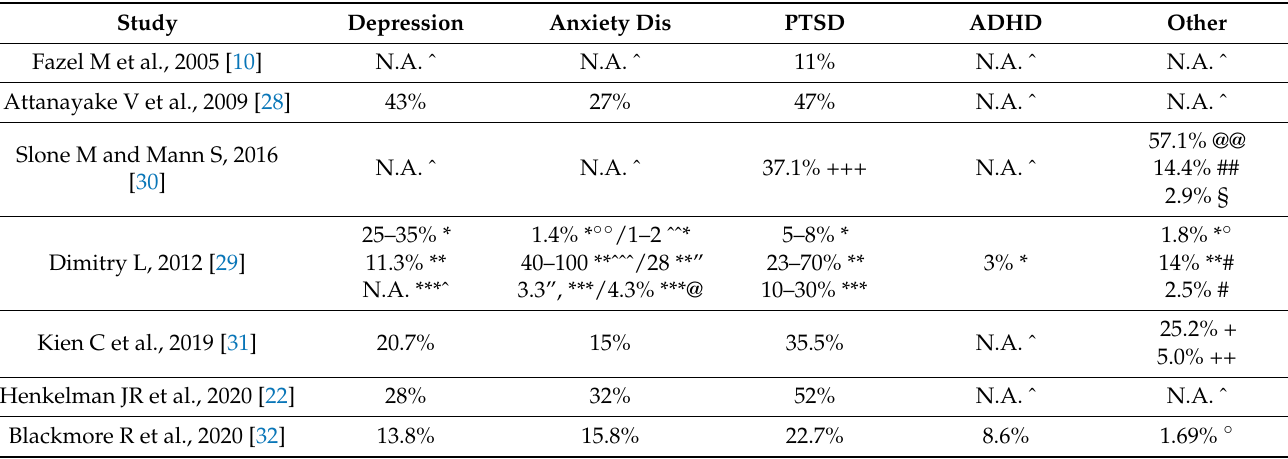
Table 5. Prevalence rates of mental disorders in systematic reviews/meta-analyses conducted on samples of